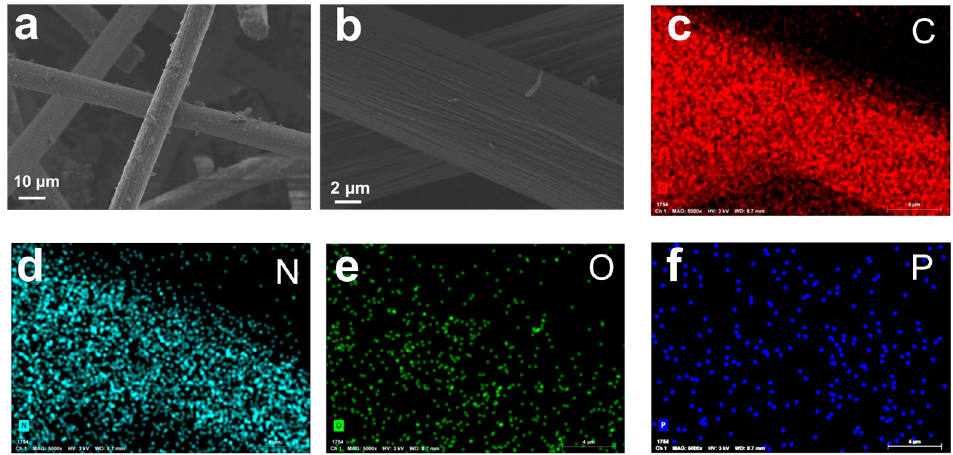
Figure 1. SEM image of ( a ) TGF/EDTMPA and ( b ) NPGF. ( c – f ) Corresponding C, N, O, and P ele- mental mapping image of NPGF.